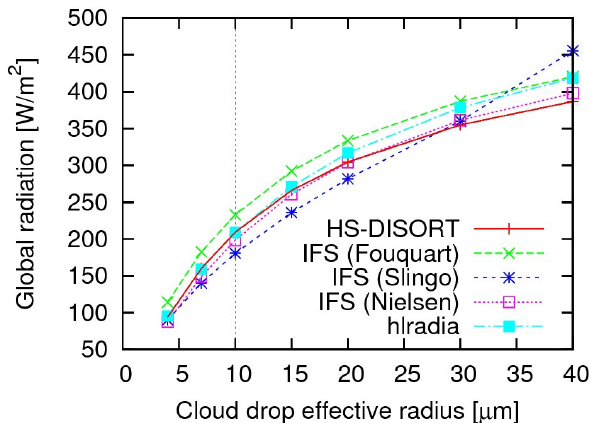
Figure 15. As for Fig. 10 but for varying r e , liq (experiment 5). The vertical dashed line at 10µm marks r e , liq used in experiment 4, 6 and 7.